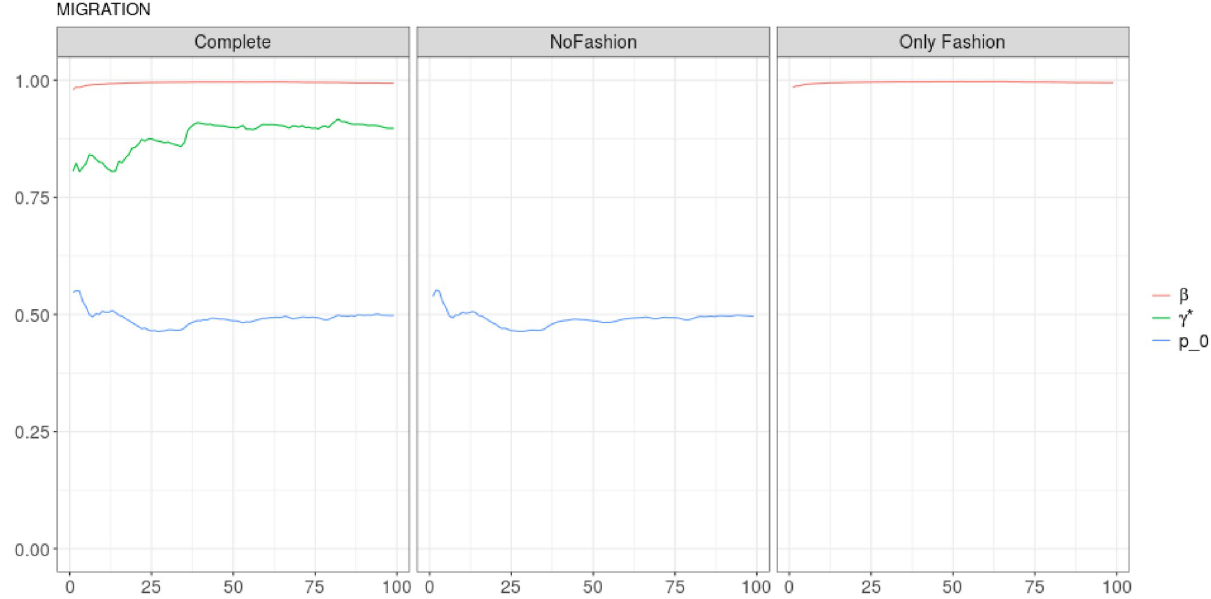
Fig 7. “Migration” ( T = 0.35, entire, D = 3 0 ): Model parameters evolution with S = 100 slots of equal size (i.e. 3673 observations). All parameters are slowly varying and converging to stable values. https://doi.org/10.1371/journal.pone.0249634.g007 debate. Human accounts show a nearly constant parameter dynamics: while β is nearly con- stant in the Complete model, γ � and p display a smooth slow variation of nearly the 10% of 0 their value, see Fig 7. The dynamics of the parameters for automated accounts is completely different, see Fig 8: in the Complete model, while β is slowly decreasing (but still experiencing